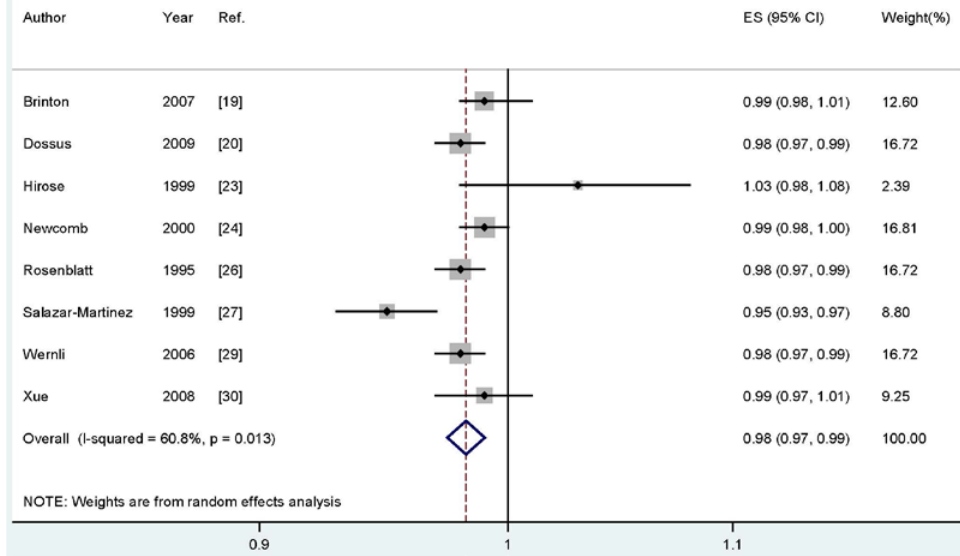
Figure 3. Dose-response meta-analyses of every one-month increase of breastfeeding and the risk of endometrial cancer. Squares represent study-specific RR, horizontal lines represent 95% CI and diamonds represent summary relative risk.